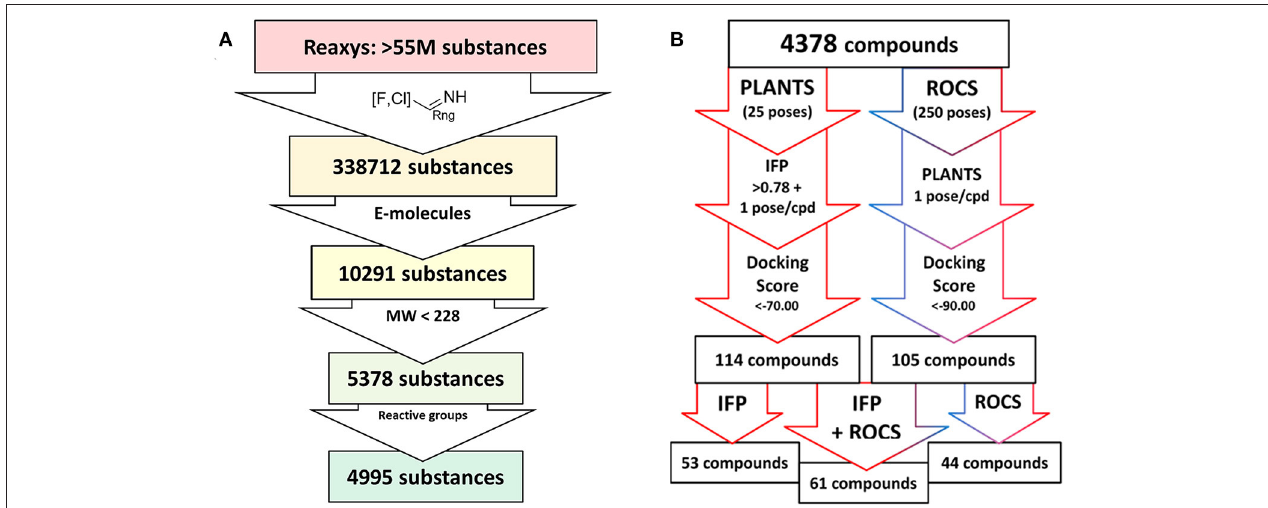
FIGURE 2 | Schematic overview of the virtual screening. (A) Extraction of commercially available heteroaromatic chlorides and fluorides from Reaxys. Every arrow indicates a filter step based on substructure, commercial availability, molecular weight, and a preliminary filter on reactive functionalities. (B) Schematic overview of the docking process based on PLANTS/IFP protocol or ROCS/PLANTS protocol of all compounds obtained from the Reaxys search.